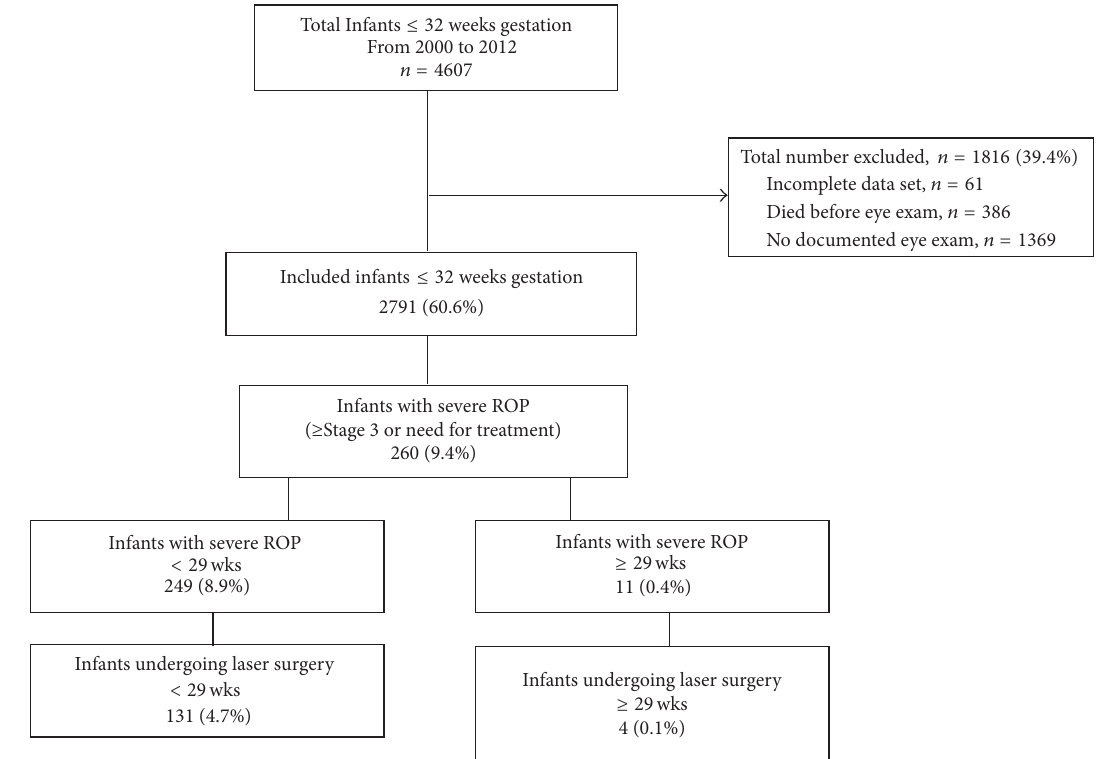
Figure 1: Study participants flow diagram. Infants were excluded due to lack of ROP screening data because of death, discharge, transfer, or ROP exam deemed unnecessary. Infants with severe ROP were categorized by gestational and/or birth weight group and then again by those in each group treated with laser surgery.